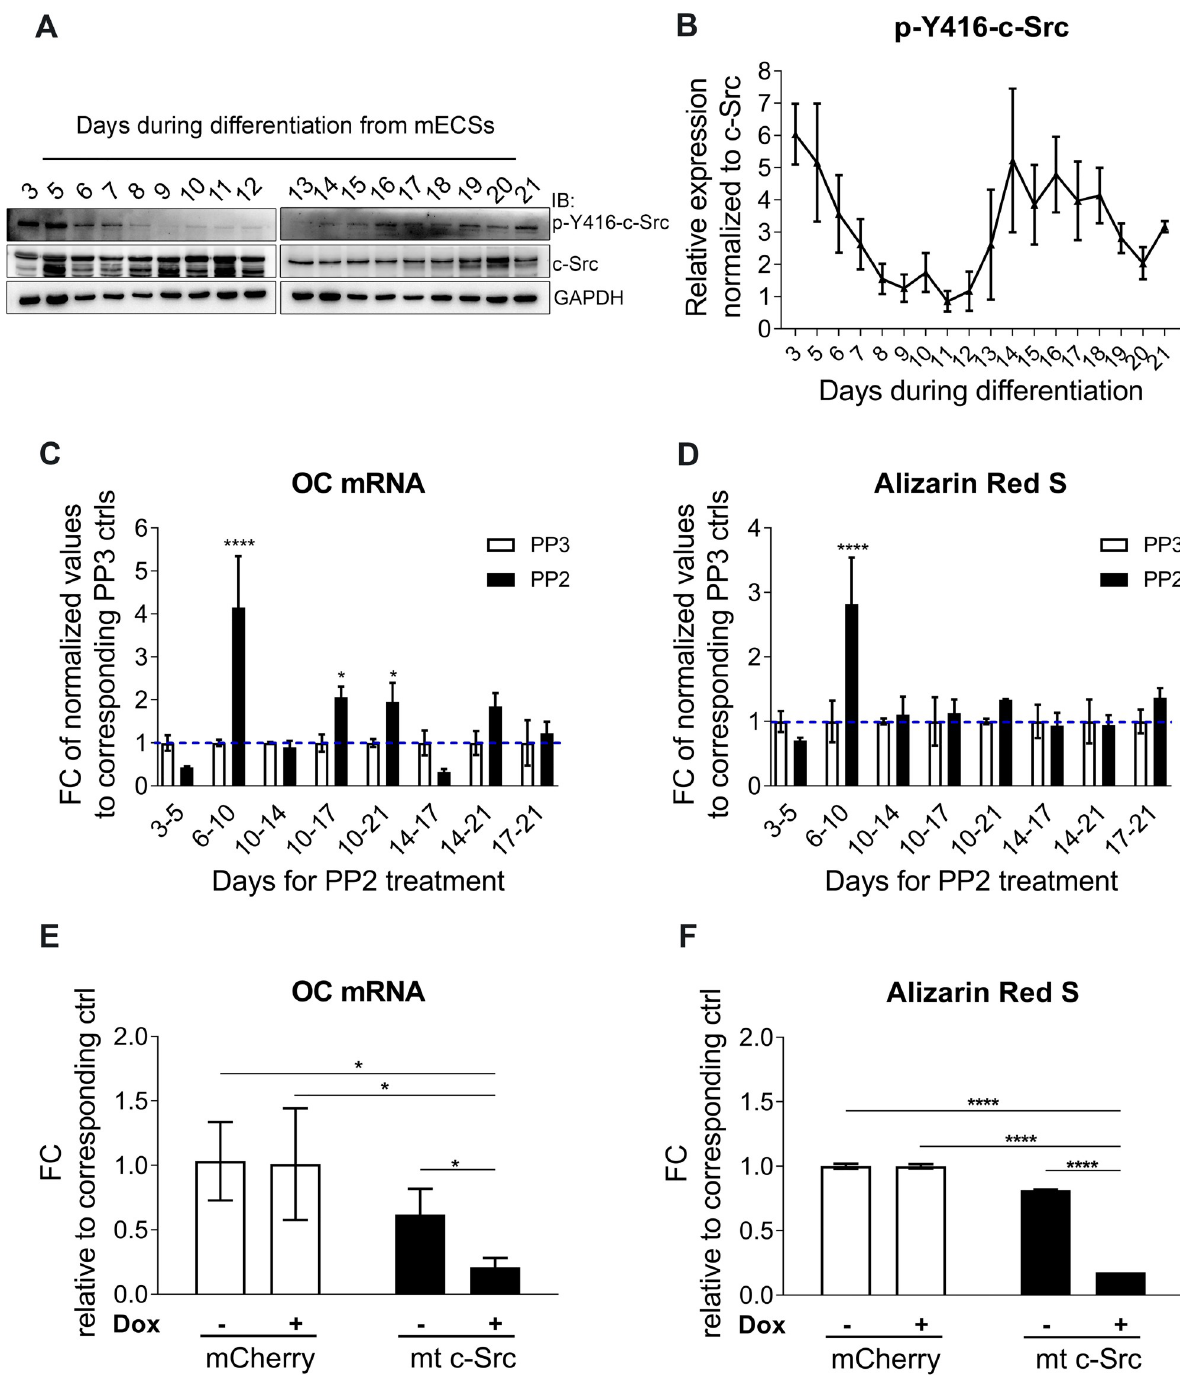
Fig 1. c-Src inhibition enhances osteogenic differentiation in mESCs. (A) c-Src activity during 21 days of osteogenic differentiation in mESCs. p- Y416-c-Src level and total level of c-Src are analyzed by immunoblotting. GAPDH served as loading control. (B) p-Y416-c-Src band densities are quantified using ImageJ. Normalized values to corresponding total c-Src and GAPDH controls are graphed. (C) Total RNA of day 21 osteo-nodules is subjected to qPCR analysis using OC primer pairs. Fold change in OC expression is calculated by normalizing PP2 treated values to their corresponding PP3 control. Values representing the mean ( ± SD) of triplicates are graphed and subjected to one-way ANOVA; F (15,32) = 15.85, p < 0.0001. Bonferroni’s multiple comparisons test indicated significant differences between PP2 and PP3 treated cells for day 6–10 ( p < 0.0001), day 10–17 ( p = 0.0161), and day 10–21 ( p = 0.0422). (D) Day 21 osteo-nodules were stained by ARS method. Absorbed stains were extracted and their concentration were quantified and normalized to their corresponding PP3 controls. Data shown represent the mean ( ± SD) of triplicates and